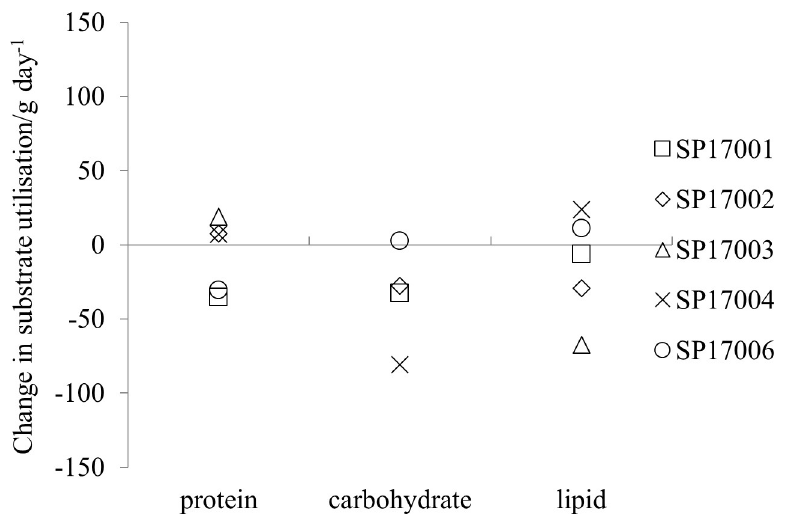
Fig 4. The change in substrate utilisation in g/day for the 24-hour measurement periods.